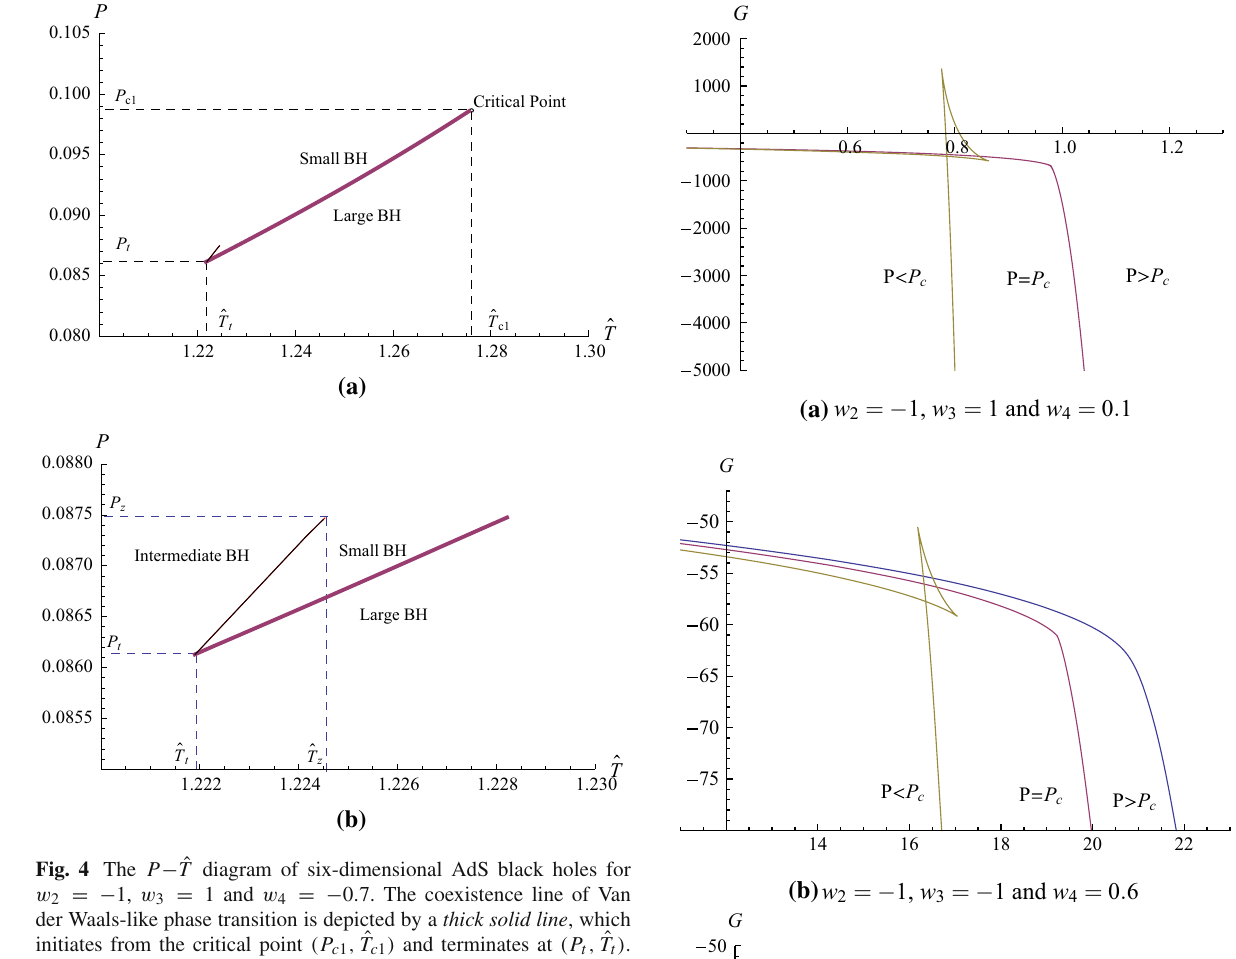
to as a zeroth-order phase transition. For three other cases in Table 1, the usual Van der Waals-like small/large black hole phase transition occurred when coupling coefficients